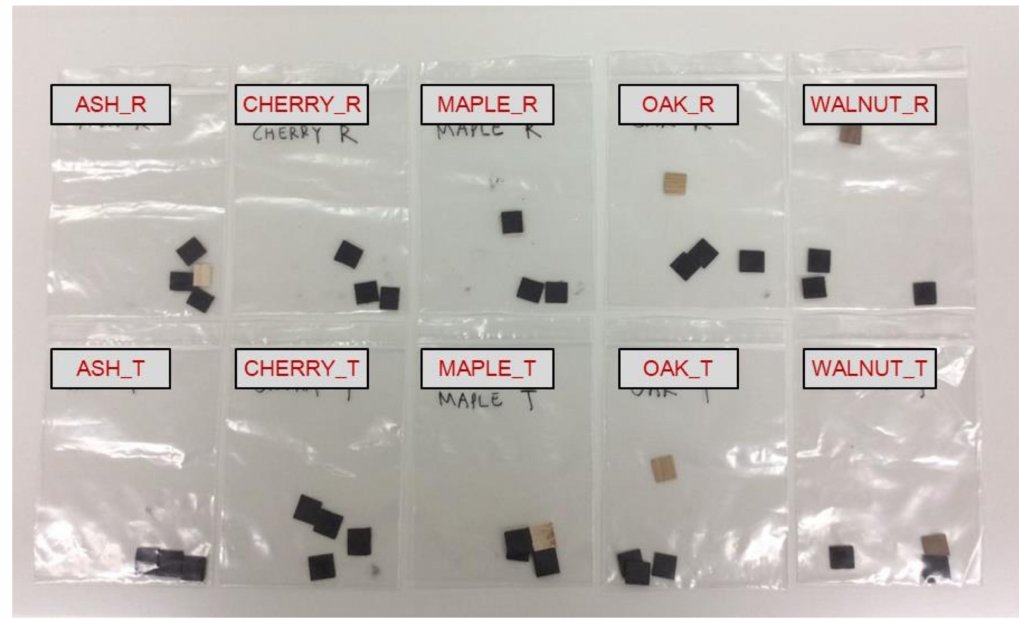
Figure 2. Sample preparation of five types of hardwoods.